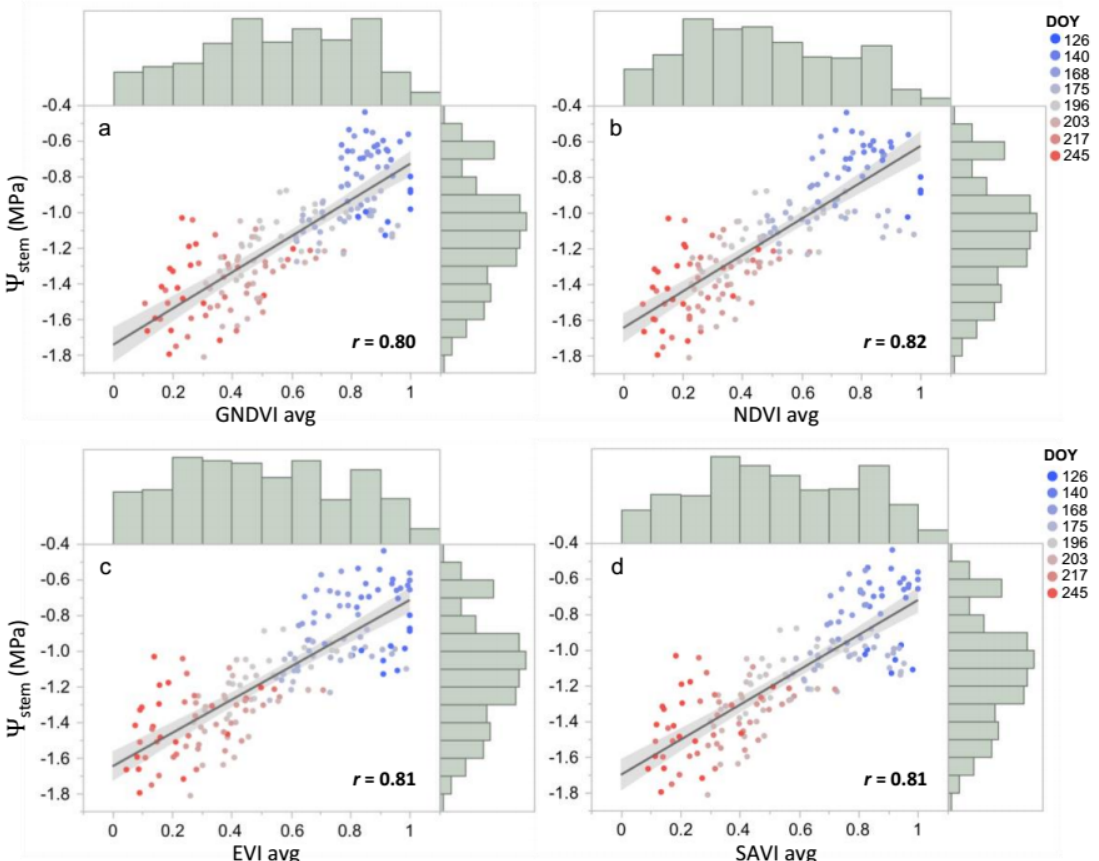
Figure 3. The correlation between the time series of VI avg and the measured Ψ stem in Mevo Beitar vineyard. Regressions presented are for the four VIs: ( a ) GNDVI, ( b ) NDVI, ( c ) EVI and ( d ) SAVI. Shaded band indicates 99% confidence intervals for the regression